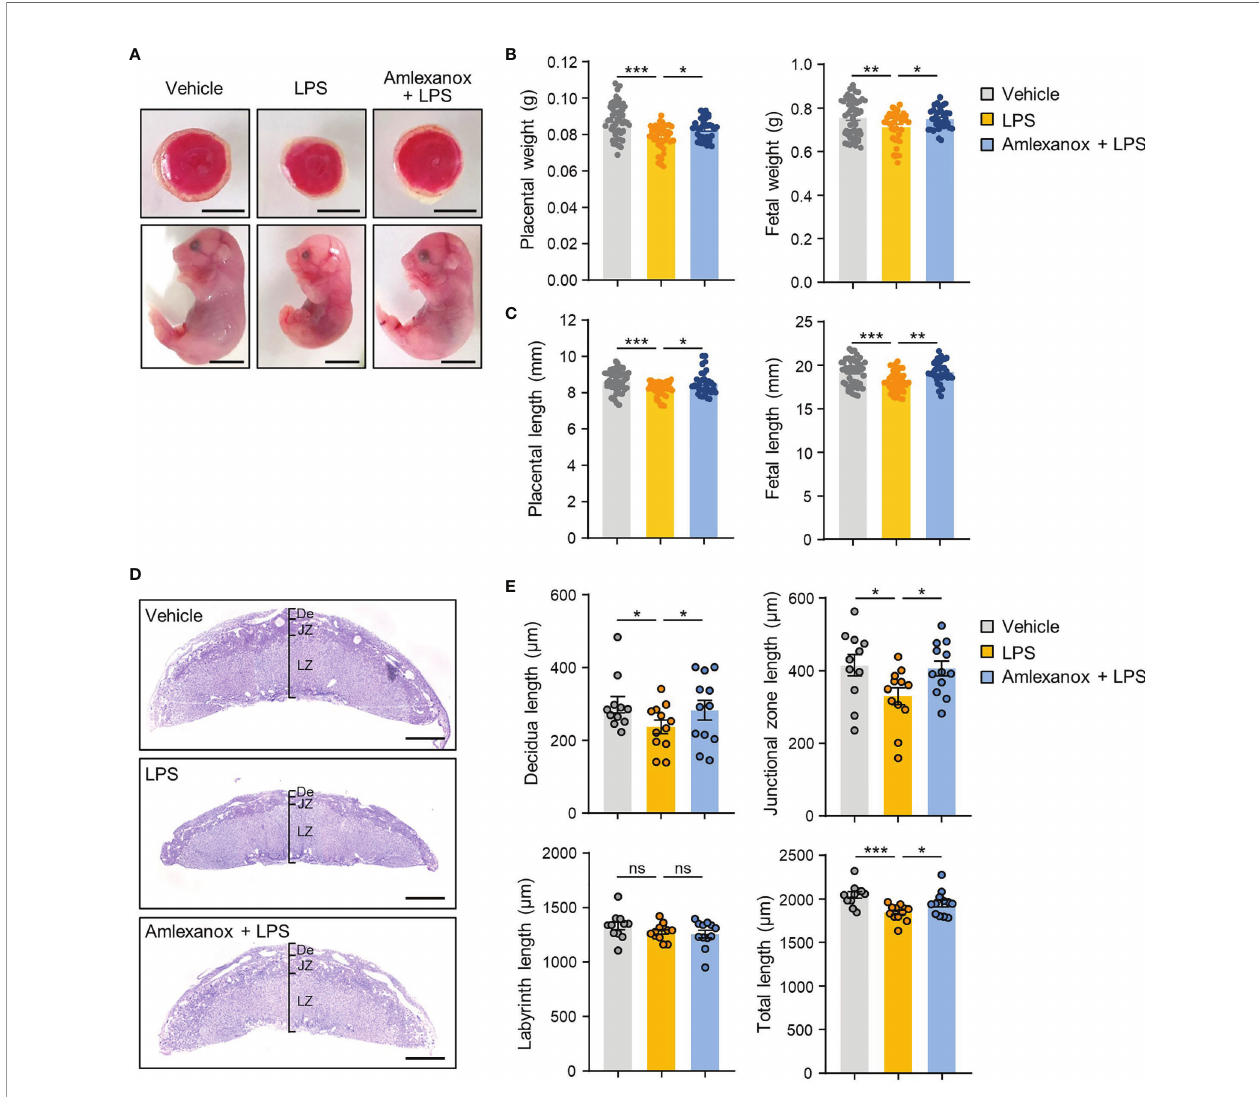
FIGURE 4 | The effect of amlexanox on the gross placental morphology in the LPS-treated pregnant mice. (A – E) Pregnant mice were intraperitoneally injected with LPS (200 m g/kg) or amlexanox (2.5 mg/kg) on gestation day 17.5, as indicated in the fi gure. (A) Representative images of fetus and placenta for each maternal group. Scale bars, 0.5 cm (B, C) Average fetal and placental weights and lengths for each group ( n = 33-50 per group). (D, E) Periodic acid-Schiff (PAS) staining of placental tissues from vehicle-, LPS-, LPS+amlexanox-treated pregnant mice at gestation day 17.5. Decidua (De), labyrinth (LZ), and junctional zone (JZ) length on the midline section was quanti fi ed ( n = 11 per group). Scale bars, 1 mm. Data are shown as means ± SEM. * p < 0.05; ** p < 0.01; *** p < 0.001; ns, not signi fi cant (One-way ANOVA, followed by Fisher ’ s LSD